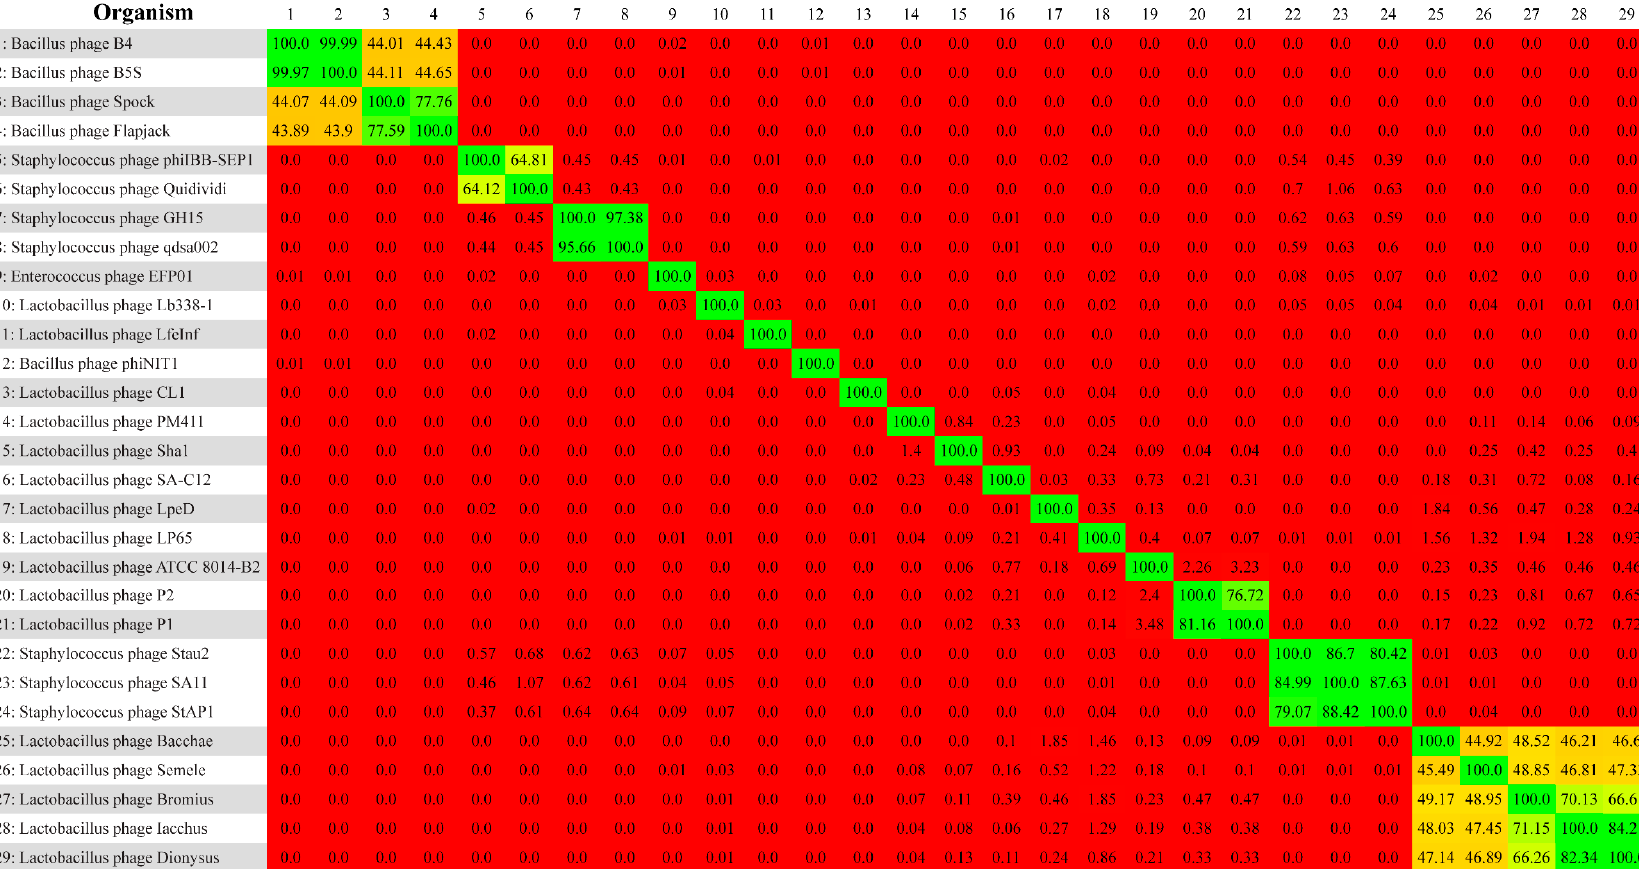
Figure 2. BLASTn heatplot generated using Gegenees. All-against-all comparisons were run with fragment length 50 bp, step size 25 bp, and threshold 0%. The studied phages (25–29) form a separate group.